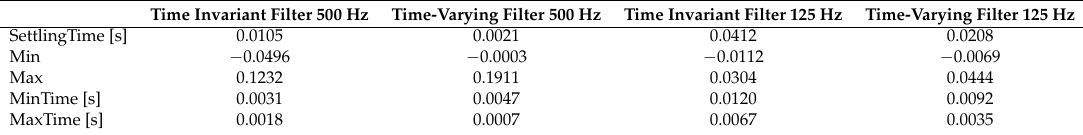
Table 3. Impulse response characteristics parameters comparison of the time invariant and time- varying